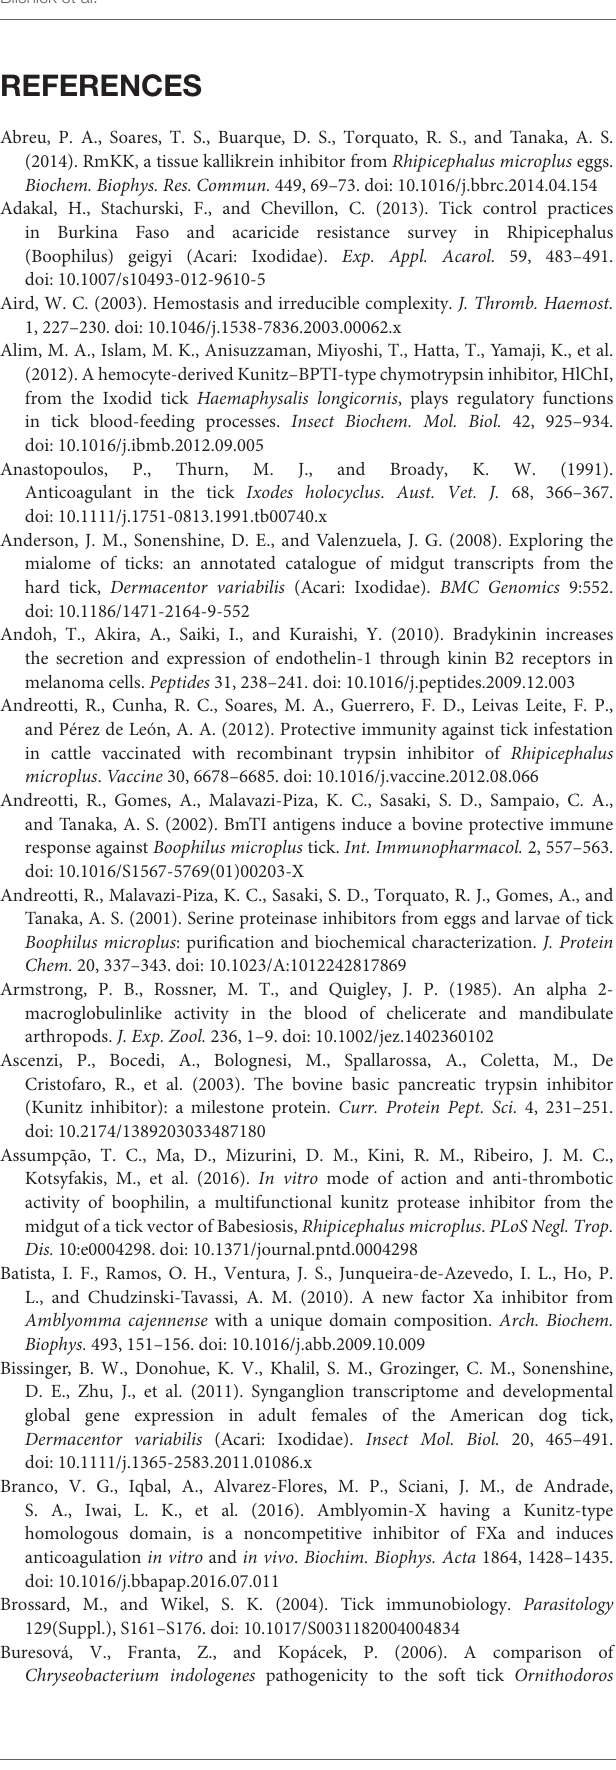
Frontiers in Cellular and Infection Microbiology |